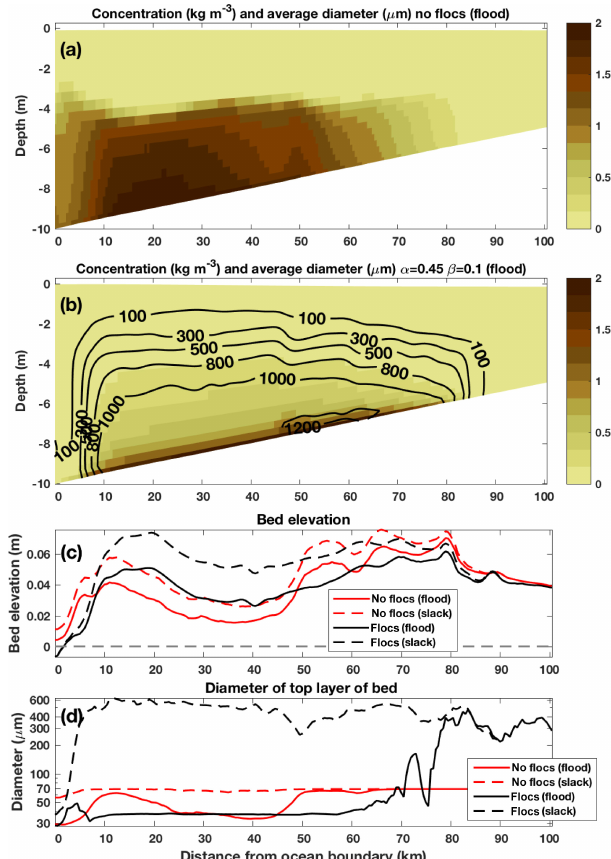
Figure 8. Comparison of estuarine turbidity maxima simulations with and without floc dynamics. (a) Two-dimensional (along- estuary and vertical) snapshot of suspended particle concentrations (shaded) without floc dynamics near the end of flood tide. All of the suspended material was in the 37µm class. (b) Snapshot of sus- pended particle concentrations at the same time in the simulation, but with simulated floc dynamics (shading), overlain by contours of mean particle diameters. (c) Along-estuary profiles of bed ele- vations for simulations without floc dynamics (red) and with floc dynamics (black) at the peak of flood tide (solid lines) and at post- flood slack tide (dashed lines). (d) Along-estuary profiles of mean particle diameter in the top layer of the seabed using the same nota- tion as (c)